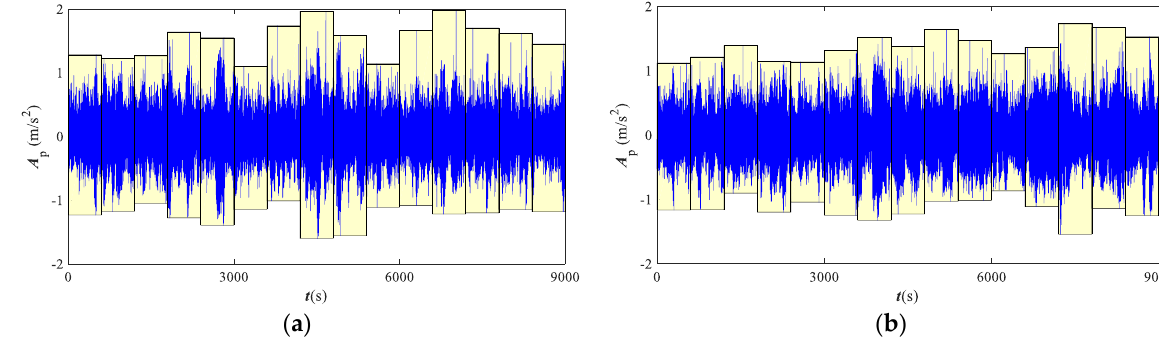
Figure 2. Ten minute accelerometric signal records at the building top with 𝑈 = 49.0 m/s, along wind (0°) ( a ) and across wind (90°) ( b ).